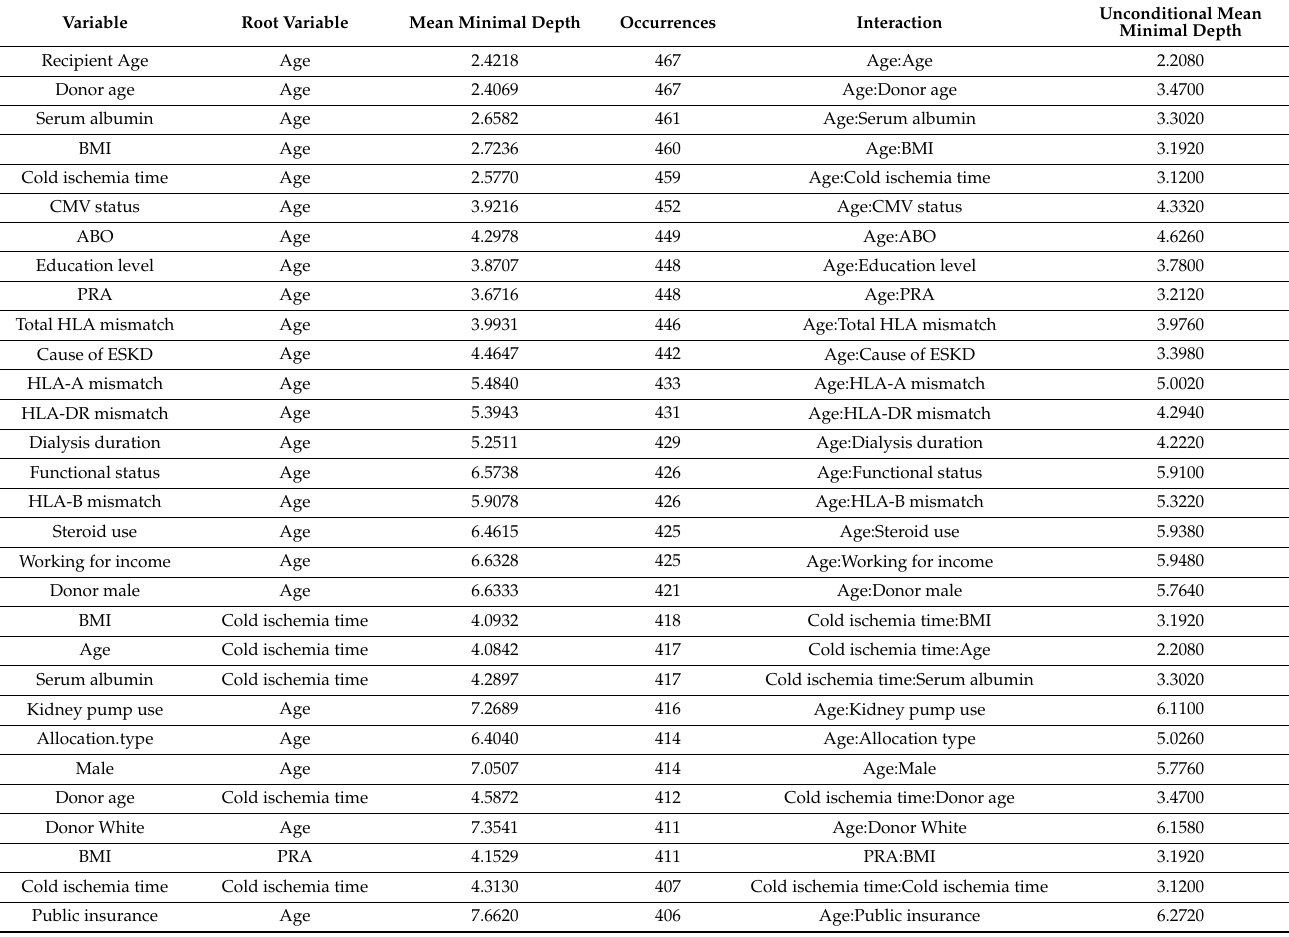
Figure 6. Mean minimum depth for the 30 most prevalent interactions variables. The bar displaying the mean condi- tional minimal depth and the line the unconditional mean minimal depth. The horizontal line presents the minimal value of the depicted statistic among interactions for which it was calculated. Abbreviations: BMI—Body mass index; CMV—Cytomegalovirus; ESKD—End-stage kidney disease; HLA—Human leukocyte antigen; PRA—Panel reactive antibody. Table 4. Top 30 interactions that appeared most